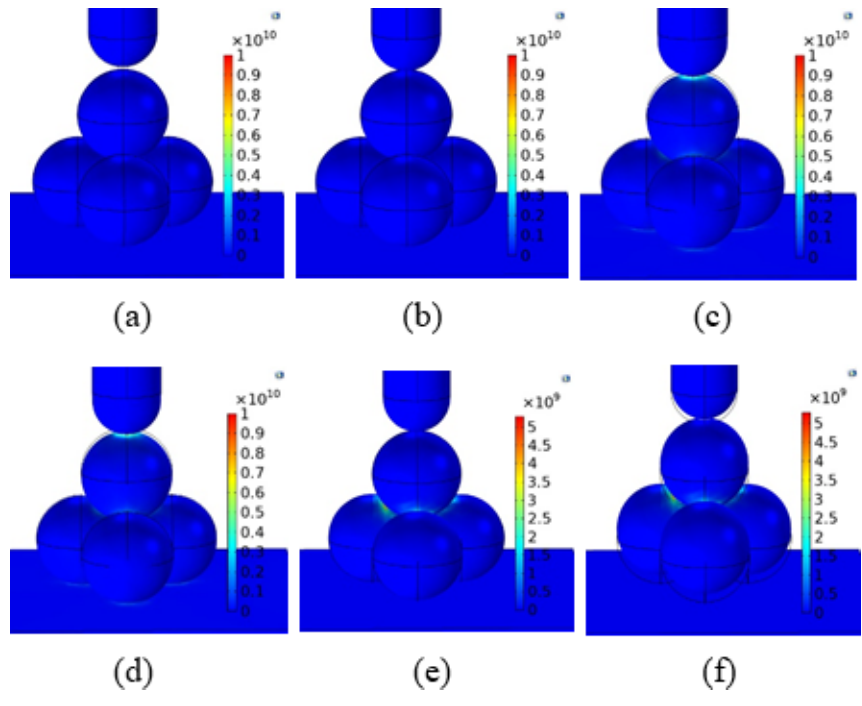
Figure 6. Process diagram of probe pickup of nanoclusters. (a) Initial state, (b) probe contacts with nanoparticles, (c) probe is moving down, (d) probe contacts with the bottom, (e) probe is moving up, and (f) nanoparticles detach from the substrate.